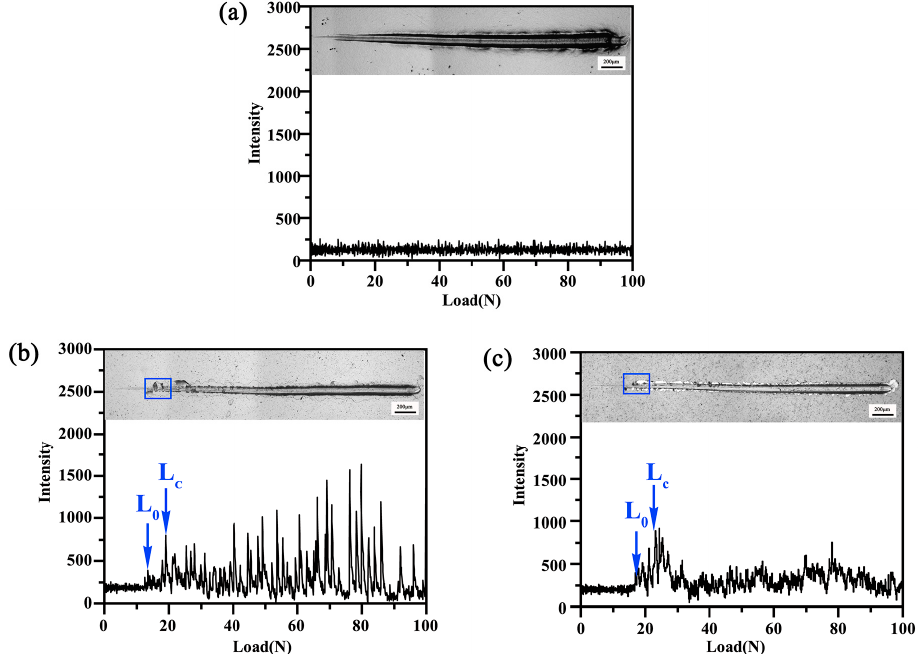
Figure 7. Surface scratch morphology and acoustic emission signals of three chromium coatings (load 100 N, loading time 60 s) ( a ) EPHC; ( b ) MSIP; ( c ) MAIP.